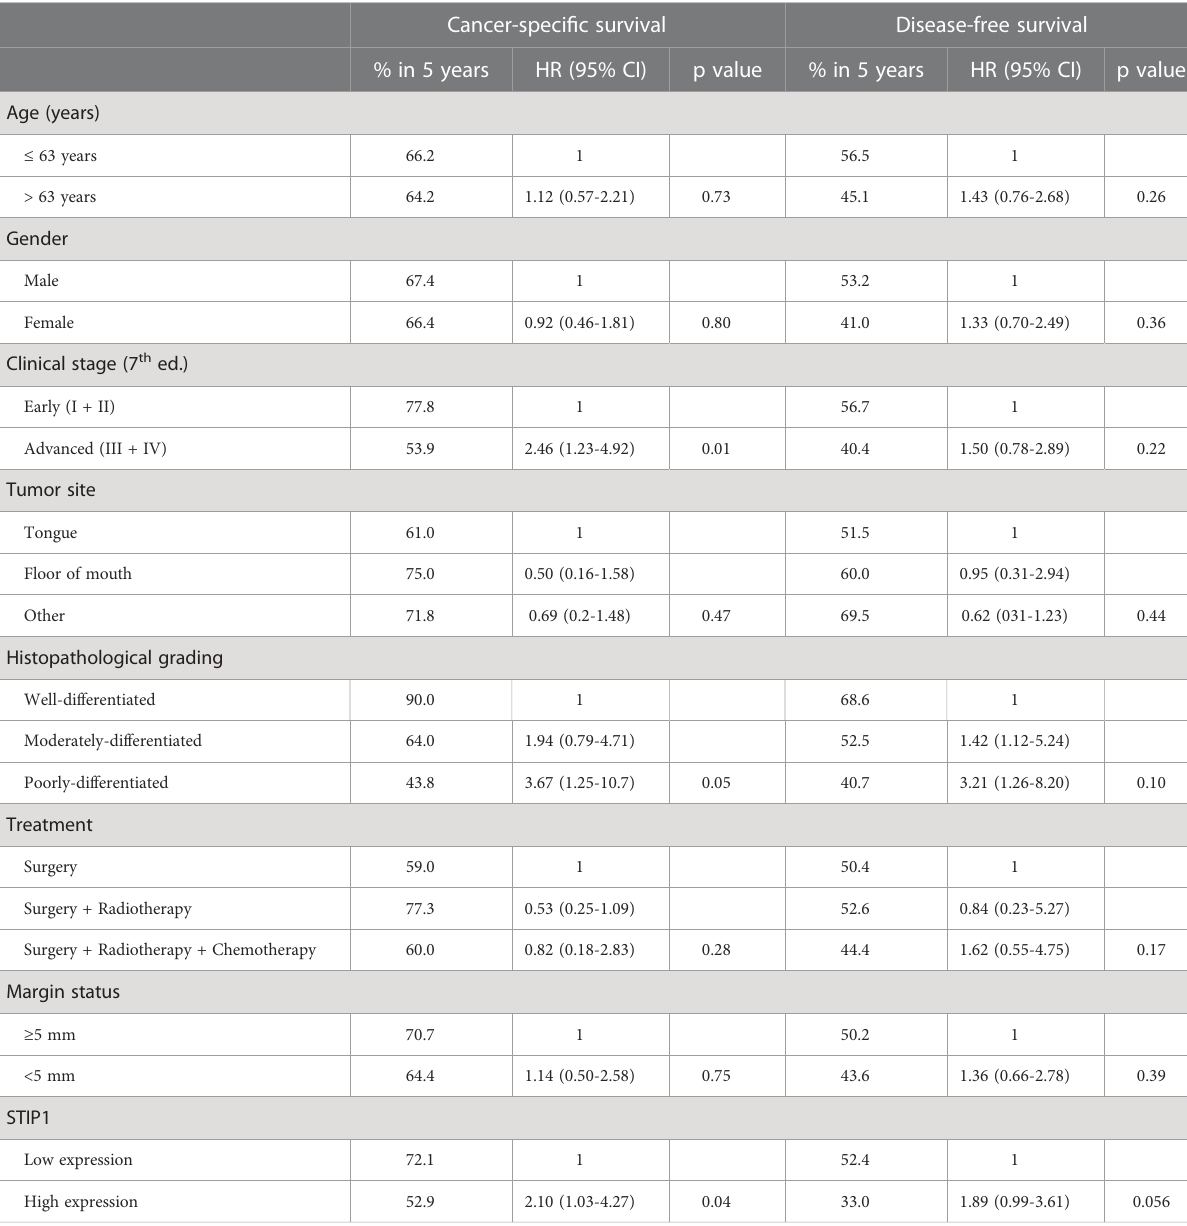
TABLE 1 Cancer-speci fi c survival and disease-free survival of 85 cases of oral squamous cell carcinoma (cohort 1) based on univariate